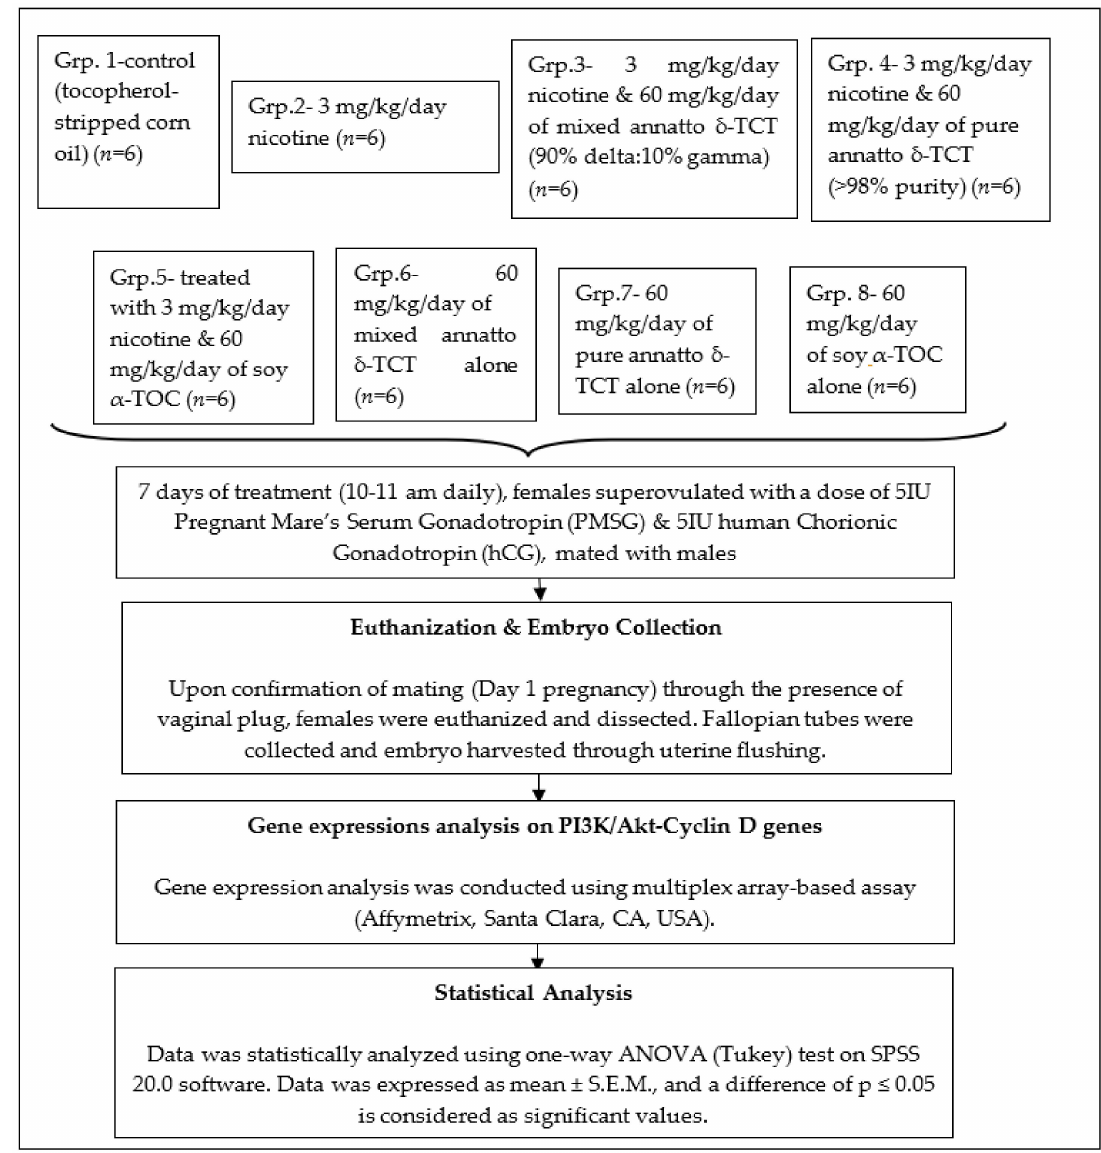
Figure 1. The overall study design as employed in the present